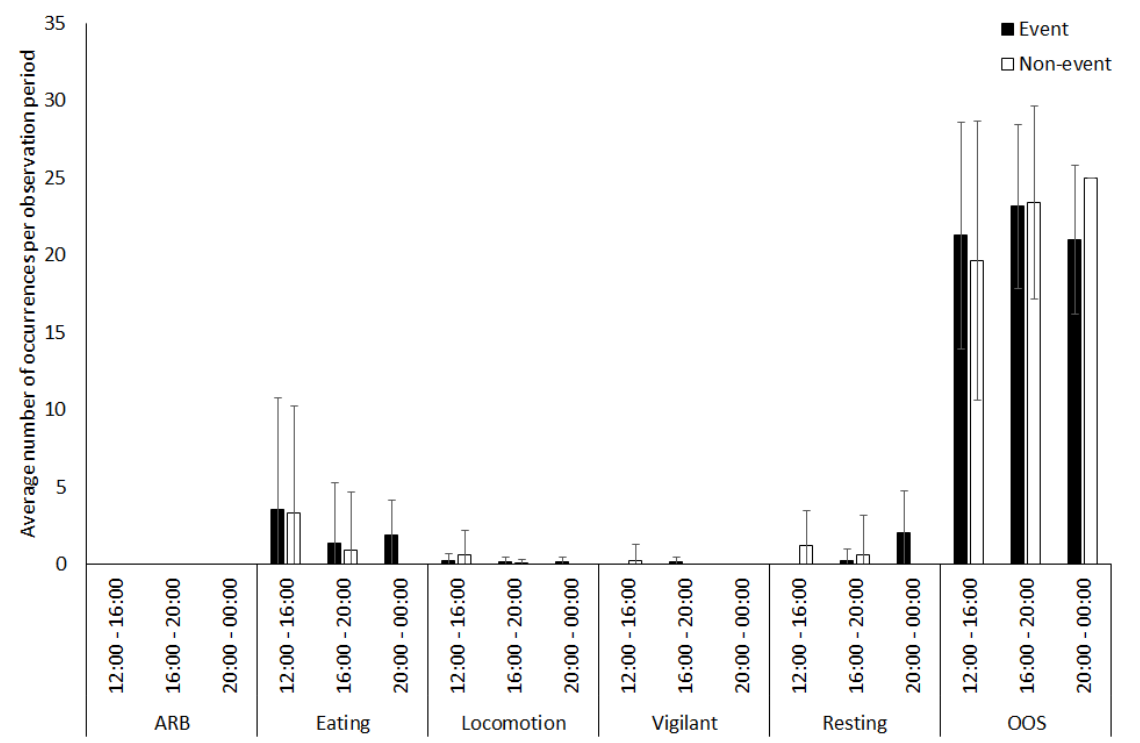
Figure 5. Activity budget data for five vicunas (average number of occurrences of each behaviours within the group per observation period ± standard deviation) from 12:00–00:00 during event nights and non-event nights. Each 12 h period was split into three time periods. ARB: abnormal repetitive behaviour, OOS: out of sight of observer.